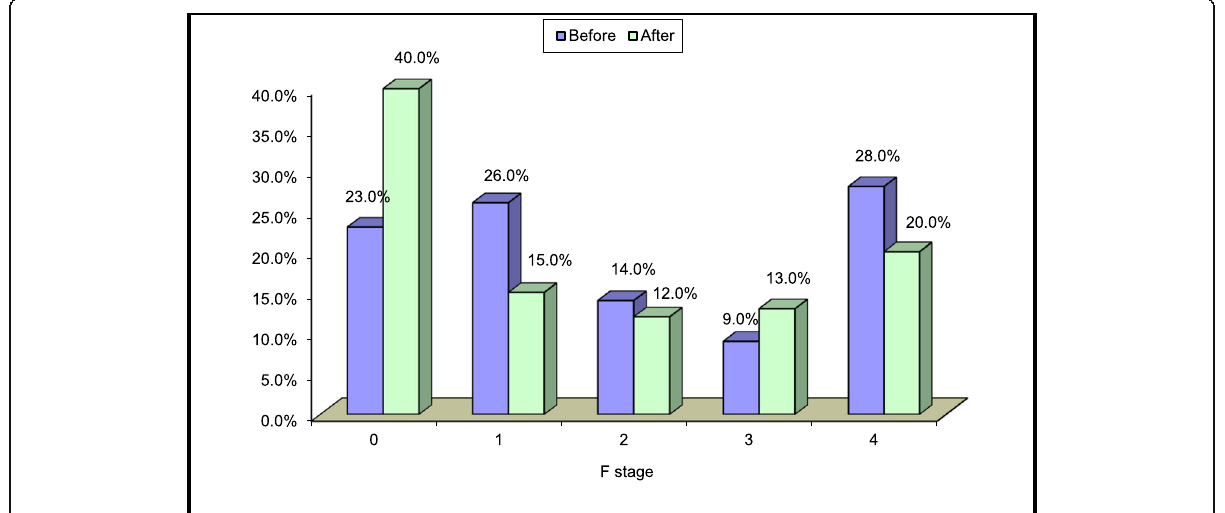
Fig. 1 Comparison of distribution of fibrosis stages among the studied patients at baseline and follow up: difference was statistically significant (<0.001)